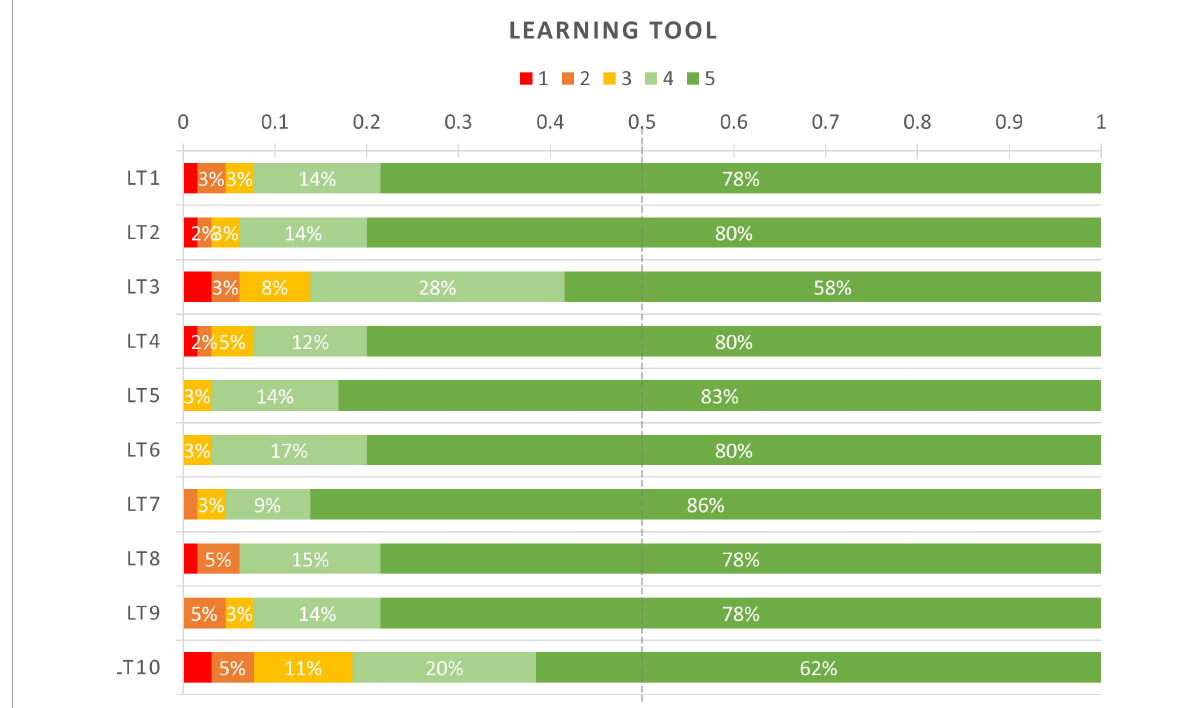
FIGURE2 Results of Likert-scale dimension of the use of virtual reality (VR) as a learning tool.